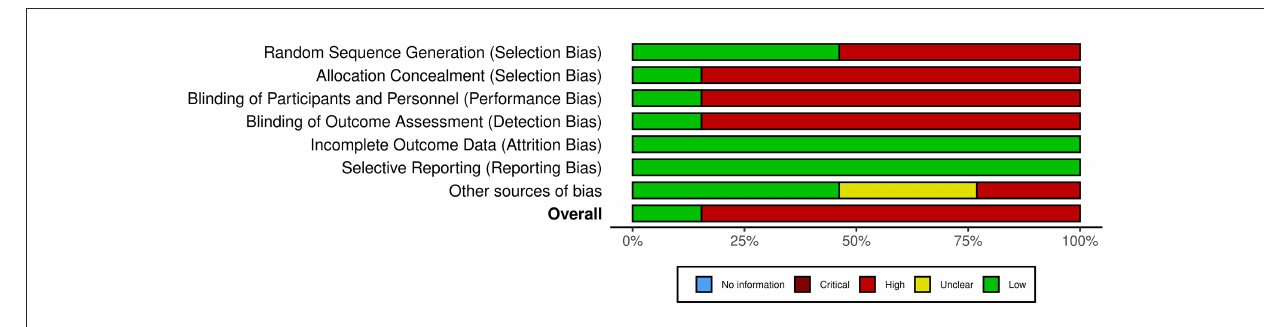
(Table 4). This states, that based on their sources of orthobiologic therapeutics, 4 studies were included using blood-derived MSCs either non-induced (native) or chondrogenic-induced (40, 57, 77, 86), 5 studies focused on bone marrow-derived MSCs (18, 29, 99– 101) from which 2 studies also included MSCs derived from adipose tissue for comparison (100, 101). Five studies included adipose tissue-derived MSCs only (27, 55, 100–102). The effect of umbilical